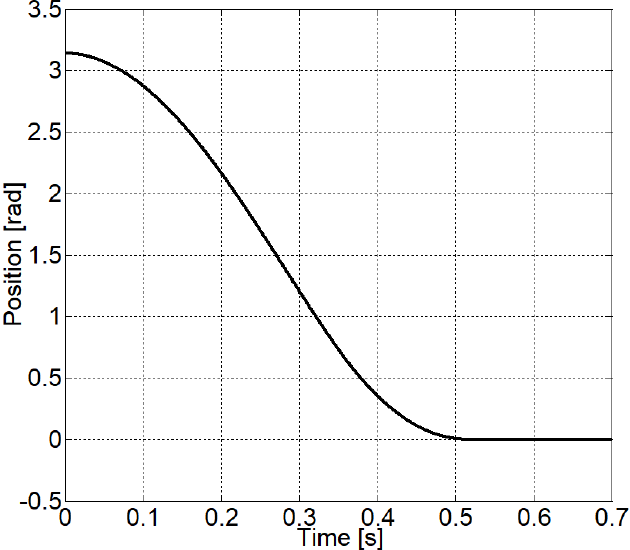
Figure 3. System’s position with the input constraint.